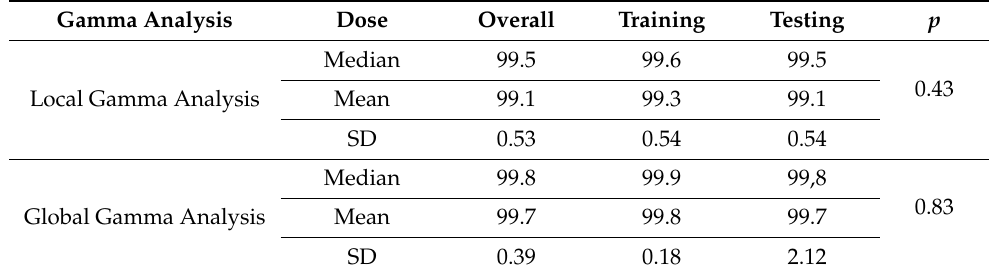
Table 3. Results of the local and global gamma analyses for each set (Overall, Training and Testing) with the 2%/2 mm criteria (10% maximum dose threshold).